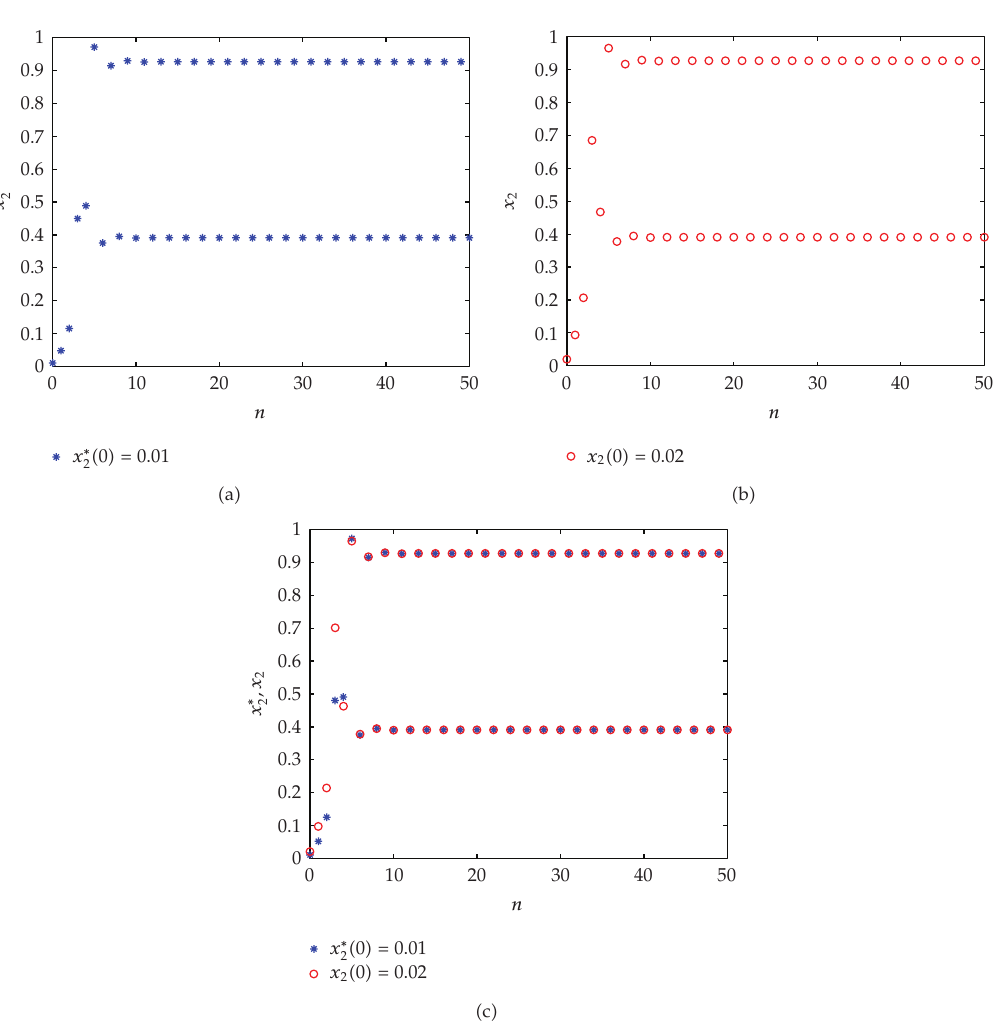
(cid:6) 0 (cid:7) (cid:8) 0 . 02 for 2 with x 2